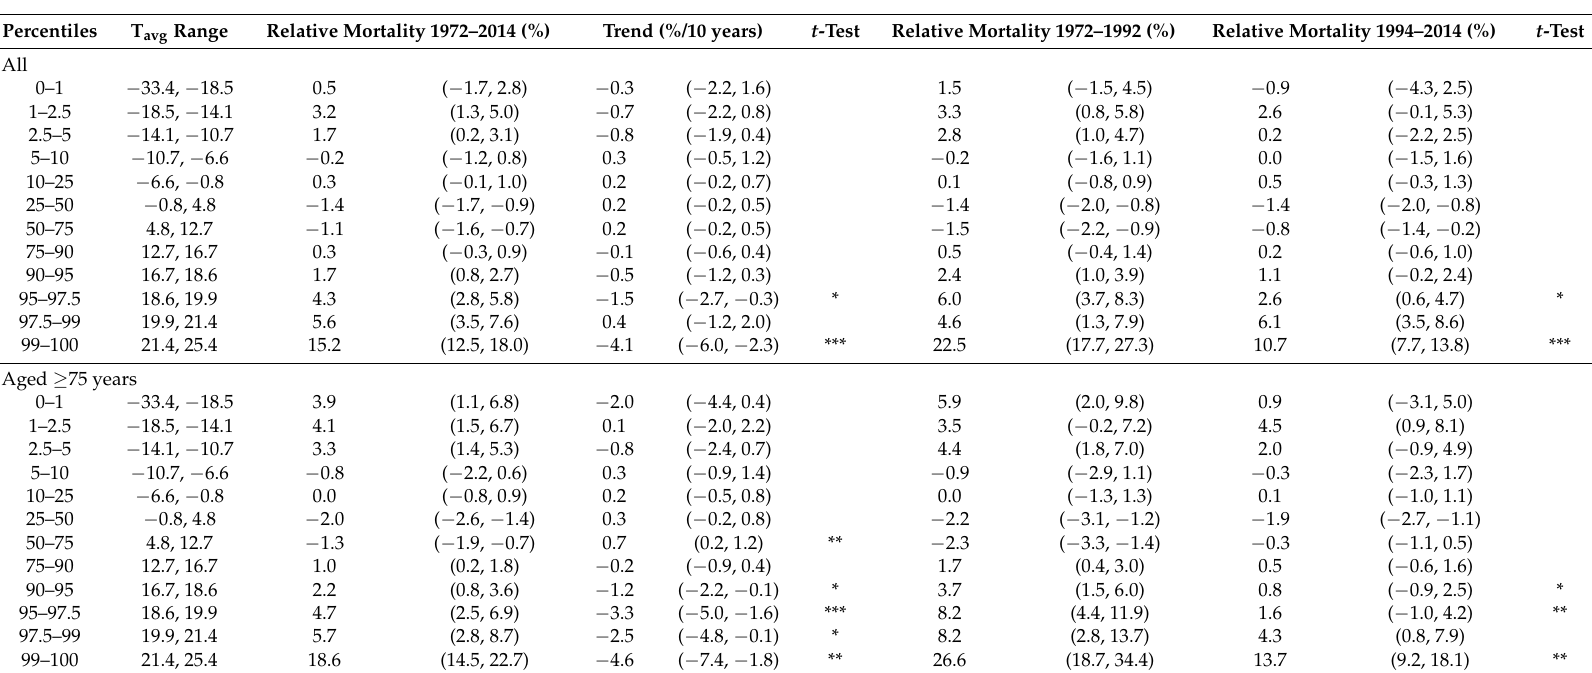
Table 2. Mean relative mortality of different age groups (95% CI) in percentiles of daily mean temperature on average in the Helsinki-Uusimaa hospital district (T avg ), and time trends in the period of 1972–2014, and two 21-year sub-periods: 1972–1992 and